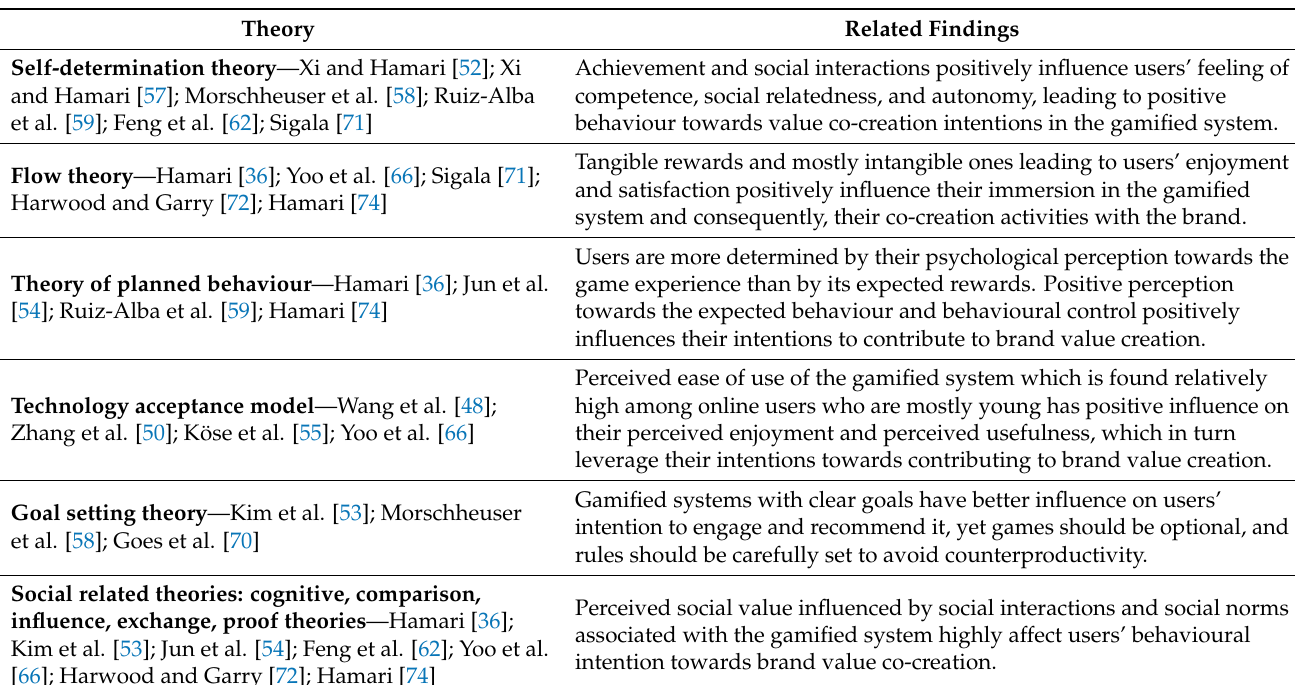
Table 2. Major underpinning theories and their related findings across the surveyed case studies. Theory Related